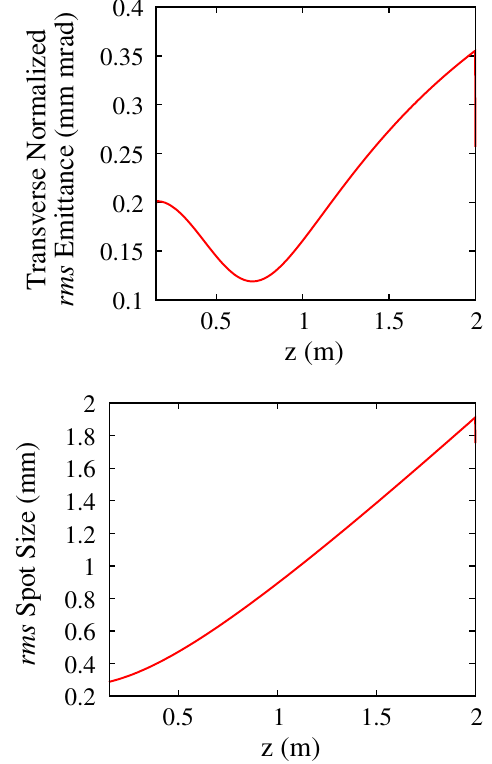
FIG. 9. Transverse normalized rms radial emittance (top) and transverse spot size (bottom) of bunch drifting after gun exit as a function of longitudinal